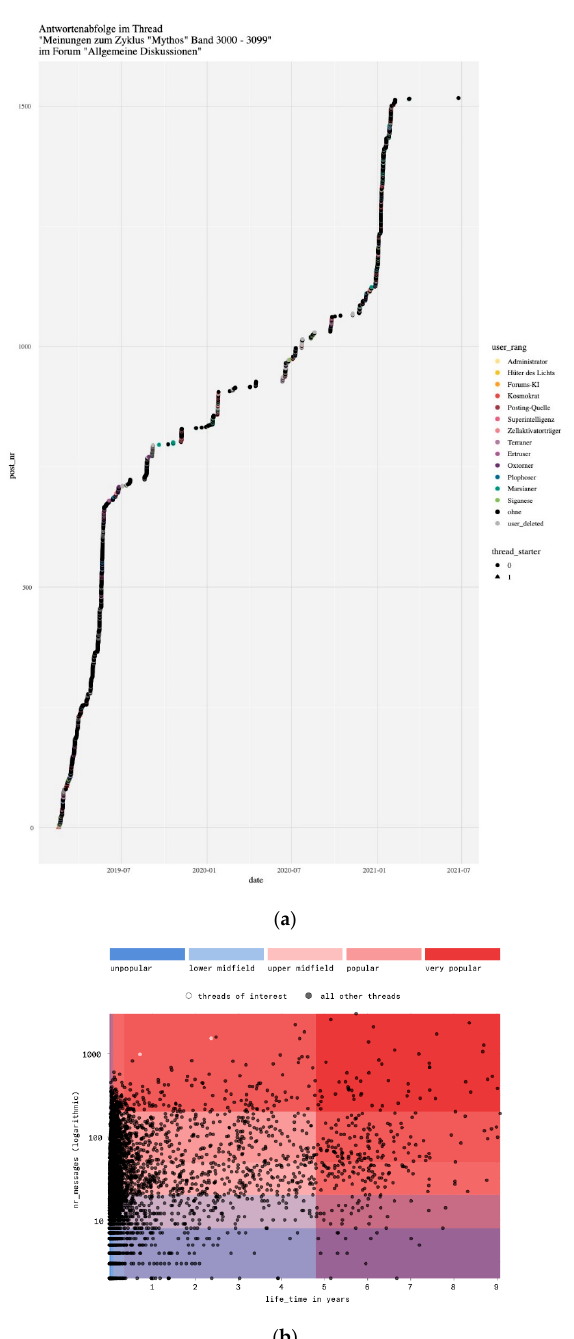
Figure 8. ( a ) Reply dynamics in thread 11119: Mythos cycle. In the graphic representation of the response dynamics in the thread, i.e., the distribution of comments over the time the thread is discussed, we can see that the discussion stops several times, does not restart until November 2020, and then develops continuously. The title “The Ilt Must Die!” (issue #3072) has been known since the end of June; issue #3072 (Gucky’s Death) is due out on 3 July 2020, and issue #3088 (Gucky’s Return) is due out on 23 October 2020. ( b ) Speed of the comments and popularity of the thematically relevant threads (without the large off-topic area). The two white dots in the red area on the top left represent the threads about issue #3072 and the Mythos cycle. There is only one thread that generates as many comments so quickly. Only discussions that run over many years and thus show a larger participation and more hits in absolute numbers are more